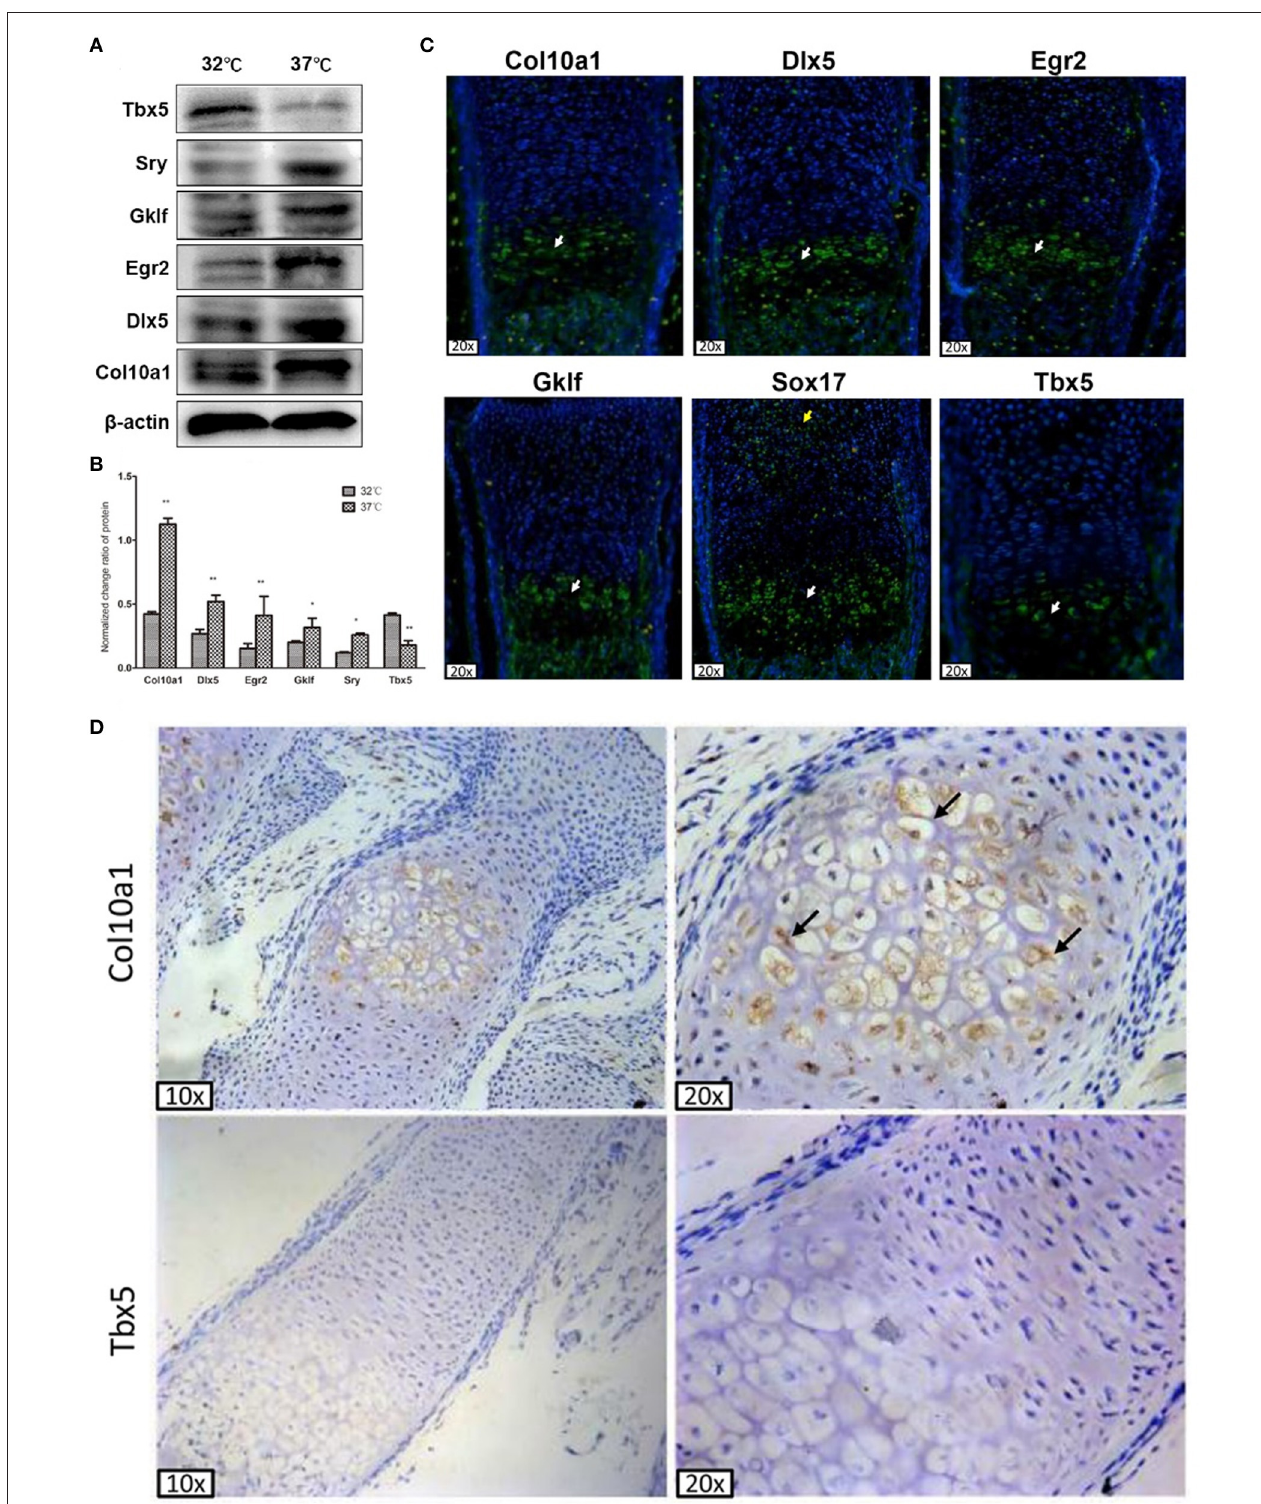
FIGURE 3 | Col10a1 and candidate TFs protein expression in hypertrophic chondrocytes. (A) Protein levels of Col10a1 , Dlx5 , Egr2 , Klf4 , and Sox17 were increased and that of Tbx5 was decreased in hypertrophic compared with proliferative MCT cells. (B) Relative protein levels of Col10a1 , Dlx5 , Egr2 , Gklf , Sox17 , and